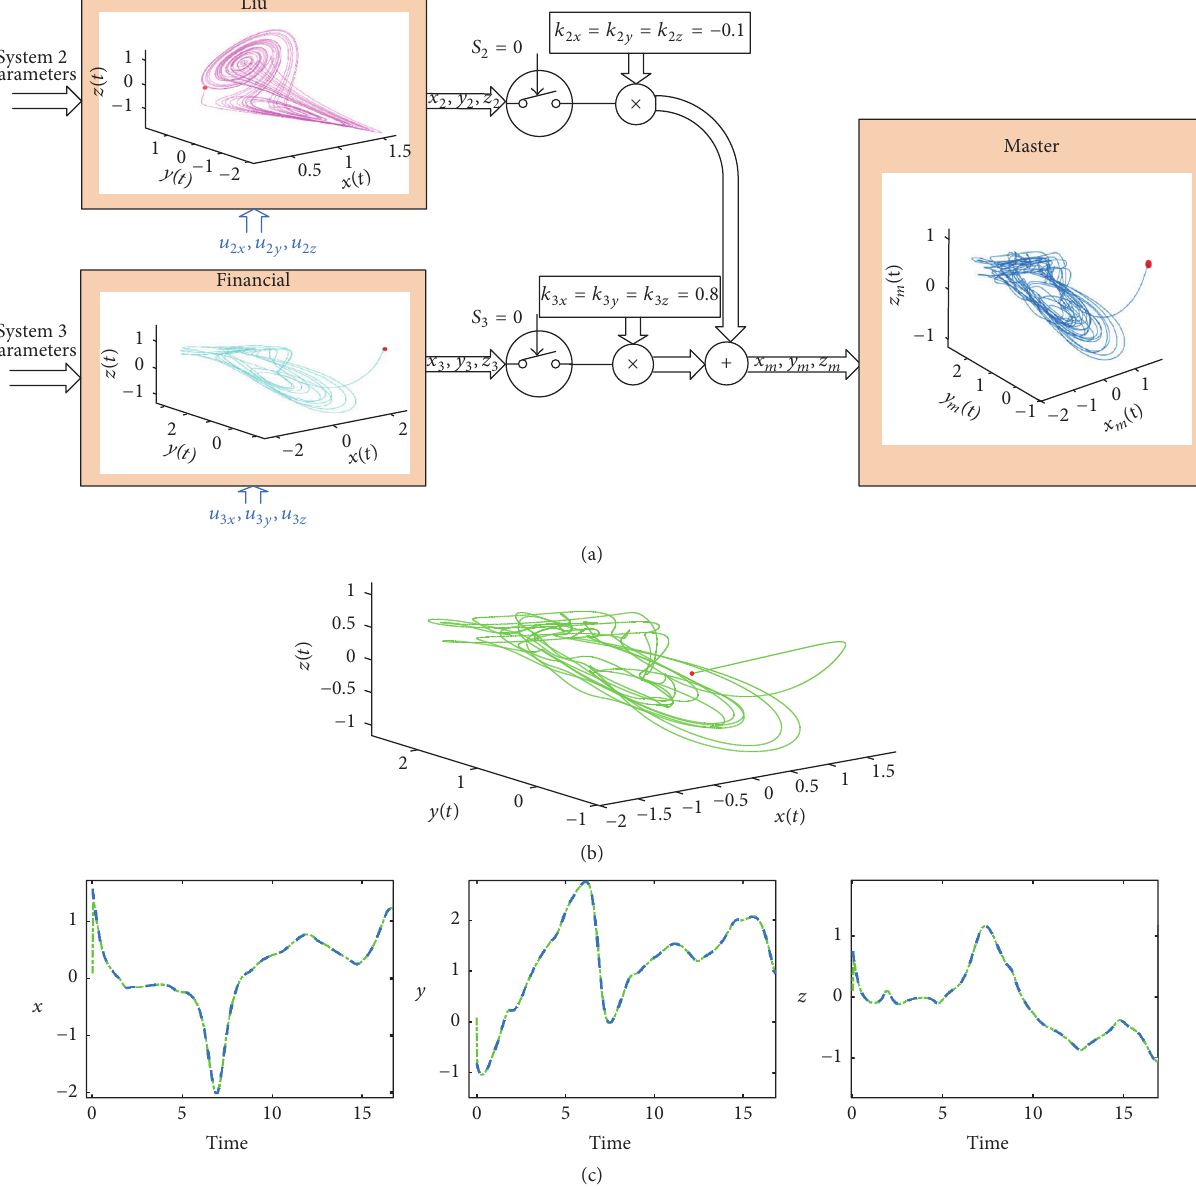
Figure 4: (a) Construction of the linear combination of Liu and Financial systems with 𝑘 2𝑥 = 𝑘 2𝑦 = 𝑘 2𝑧 = −0.1 and 𝑘 3𝑥 = 𝑘 3𝑦 = 𝑘 3𝑧 = 0.8 , (b) attractor of the slave system successfully synchronized, and (c) time series of both master and slave systems successfully synchronized.